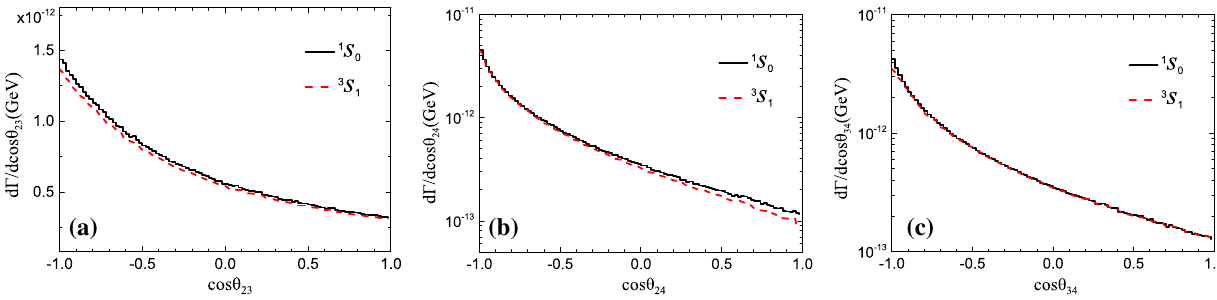
FCNC channels, those background should be taken into con-